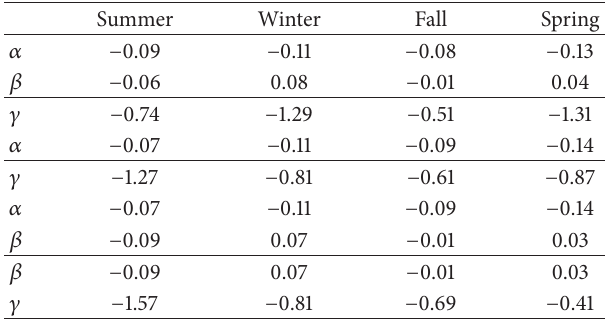
Table 3: Mean values of the obtained coefficients ( 𝛼 , 𝛽 ), ( 𝛼 , 𝛾 ), ( 𝛼 , 𝛽 , 𝛾 ), and ( 𝛽 , 𝛾 ) for the four